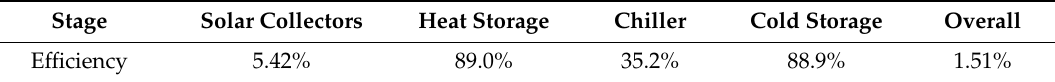
Figure 18. Stages of the energy and exergy flow in the cooling mode of the HVAC solar system of CIESOL. ffi ciency, of the HVAC system in cooling mode. Table 6. Percentage exergy efficiency, of the HVAC system in cooling mode. Table 6. Percentage exergy e